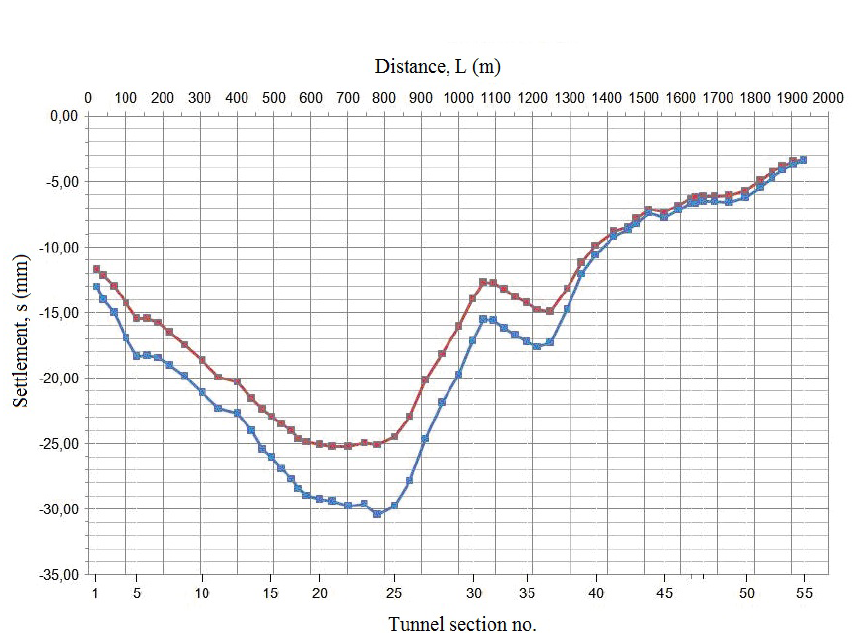
Figure 4. Subsidence variation by the profiles AA (cid:48) (the red line) and BB (cid:48) (the blue line) along the ABT route at a distance of 30m from the tunnel walls (see Fig. 3). Sections 46a and 47a are marked by small dashes at the lower abscissa